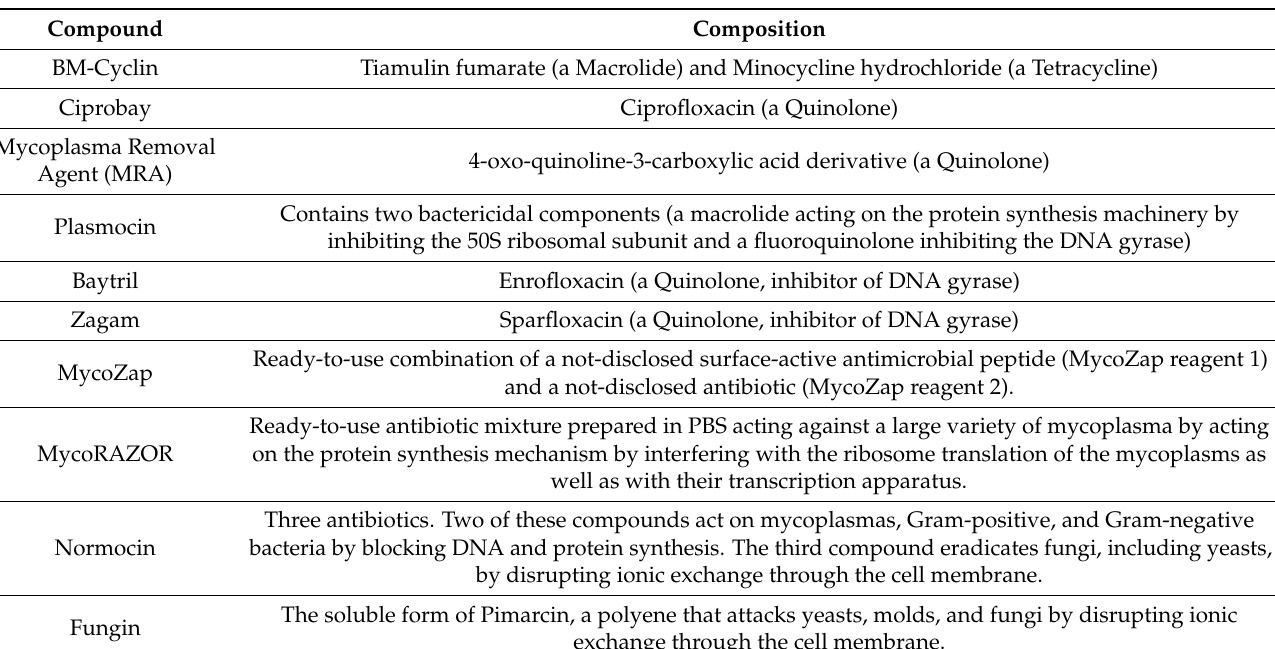
Table 3. Compounds used for removal of Mycoplasma from contaminated cell